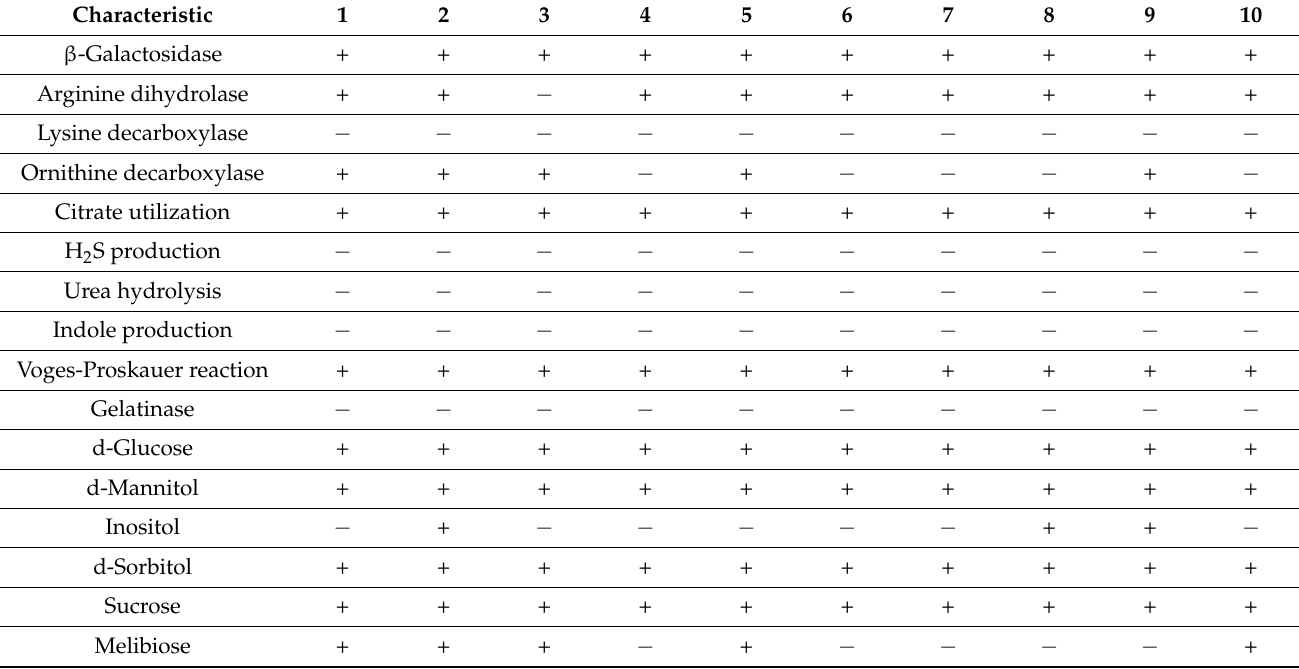
Table 2. Phenotypic features of strain FY-07 and strain types of Kosakonia species [4–7]: 1, FY-07; 2, Kosakonia oryzendophytica ; 3, Kosakonia sacchari ; 4, Kosakonia pseudosacchari ; 5, Kosakonia oryzae ; 6, Kosakonia quasisacchari ; 7, Kosakonia radicincitans; 8, Kosakonia oryziphila ; 9, Kosakonia arachidis ; 10, Kosakonia cowanii . +, positive; − ,